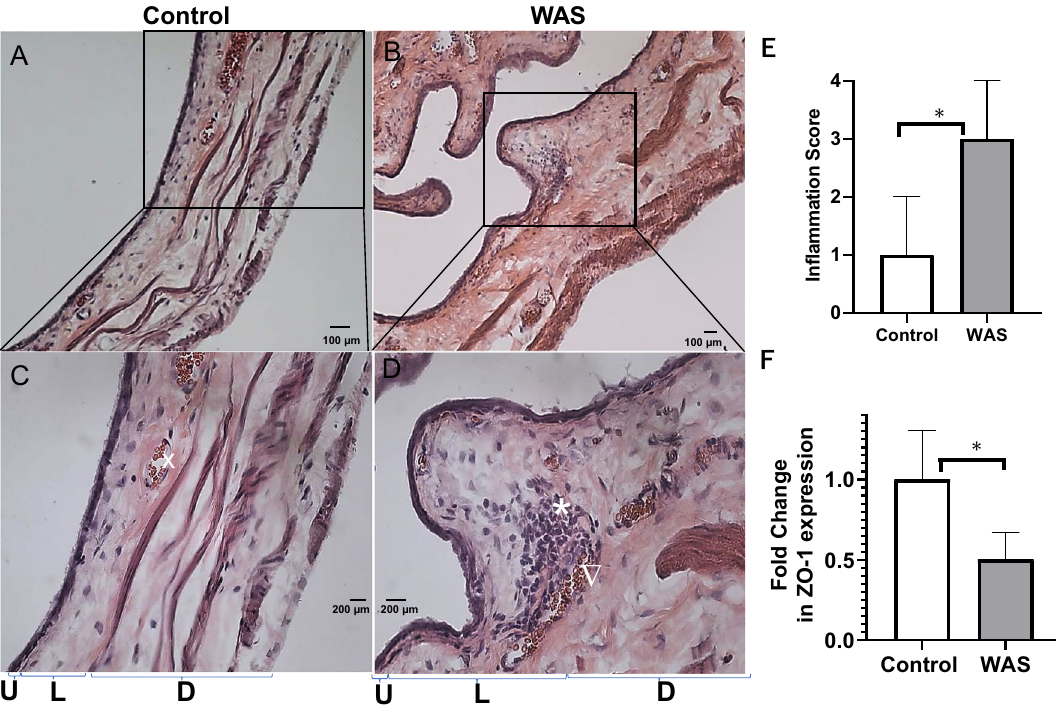
Figure 3. MRI successfully visualizes the sandwich of lamina propria (L) layer between the tissue layers of mucosa (U) and detrusor (D) and spatial separation of layers on MRI predicted the histological differences noted on H&E staining of rat bladder harvested prior to PS exposure from both groups. Compared to the histology of control rats ( A – C ), tissue sections from WAS group ( B – D ) exhibited a relative thinning of mucosa (U) with the decrease in the number of cell layers, expansion of lamina propria (L) from edema as evident from the relative expansion of L and D layers of WAS group compared to the control group (bladder wall thickening), focal areas of mononuclear inflammatory cells (*), venous congestion and elongated blood vessels (telangiectasia ∇ ) together supporting a prominent role for inflammation in WAS group even without PS exposure ( D ). ( E ) A significant elevation in the median semi-quantitative score of inflammation in WAS group relative to the control group (plot of median and interquartile range as error bars, n = 4, * p < 0.0001, Mann–Whitney Test) reflects the conspicuous absence of inflammatory cells in control group ( A – C ), a circular shape (x) instead of elongated blood vessels and mucosa with multiple layers and thinner bladder wall signifying a relative absence of edema compared to WAS group ( B – D ). ( F ) WAS exposure evokes barrier dysfunction per se even in the absence of PS exposure as evident from histological analysis and the thinning of mucosal layers is corroborated by the downregulation of tight junction protein ZO-1 in the mucosa of WAS group. Values are Mean ± SD; * p < 0.05, unpaired t